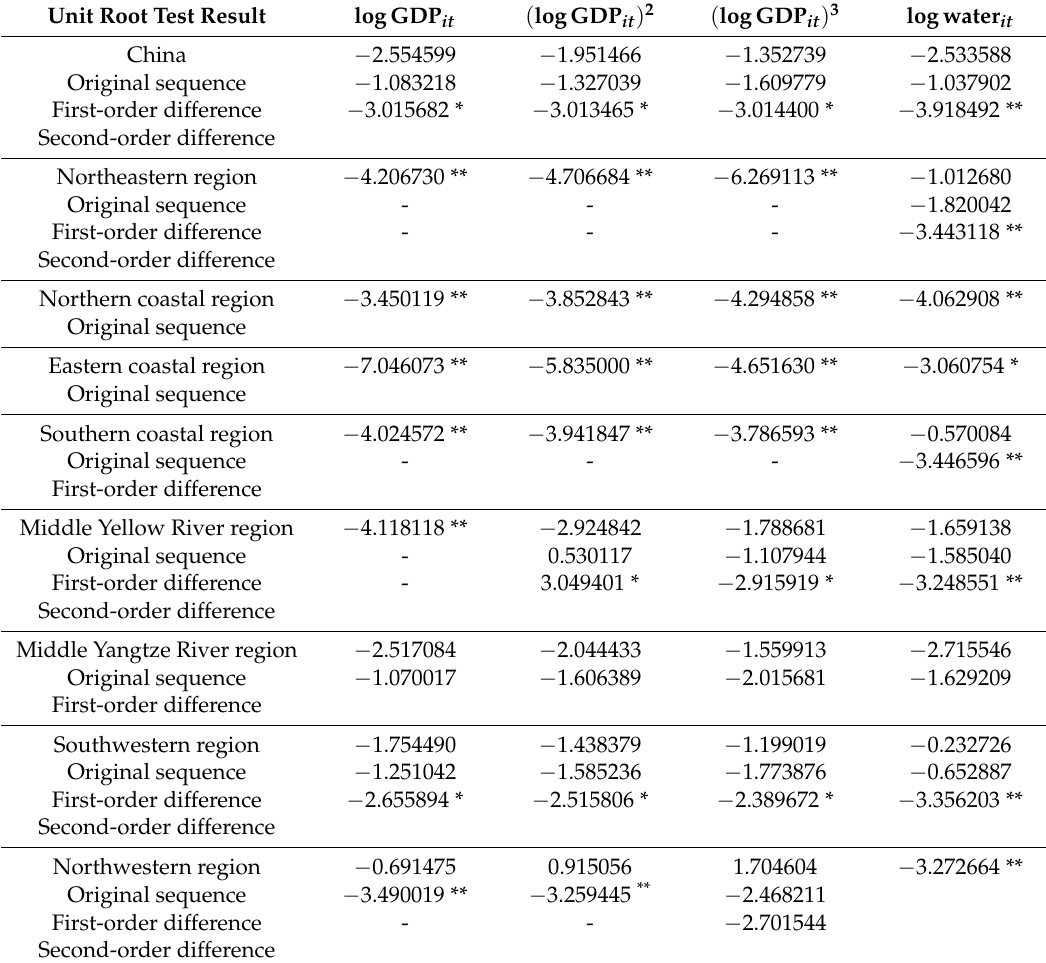
Table 2. Unit root test results of panel